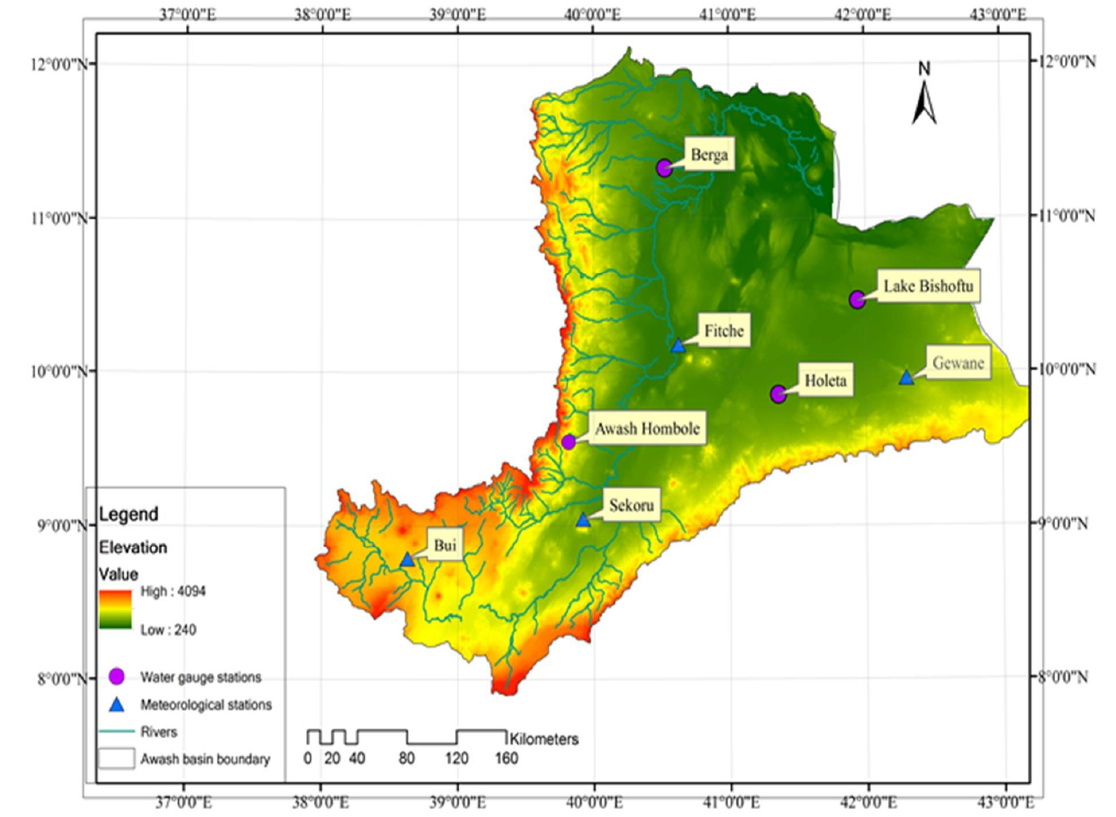
Figure 1. Location map of the study area.